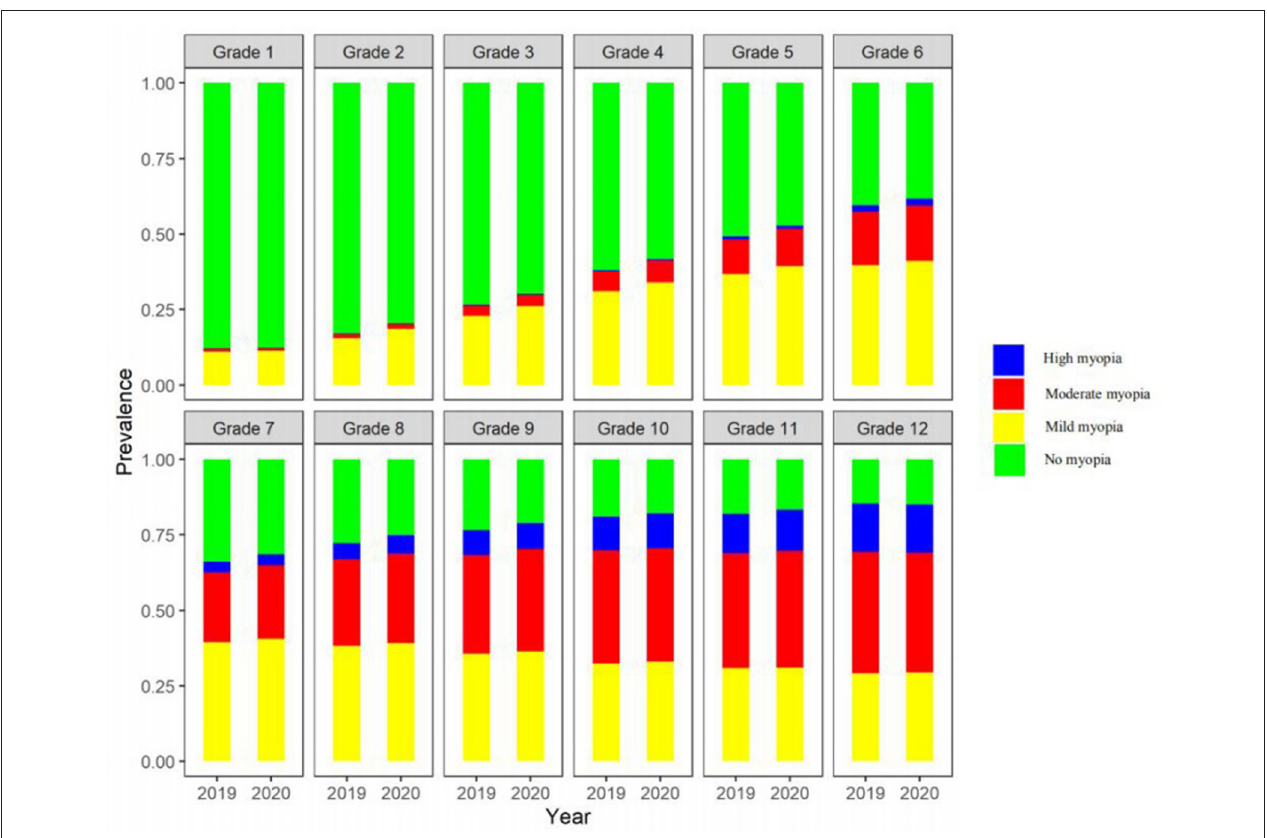
FIGURE 2 | The prevalence of myopia in primary and secondary school students according to grade.